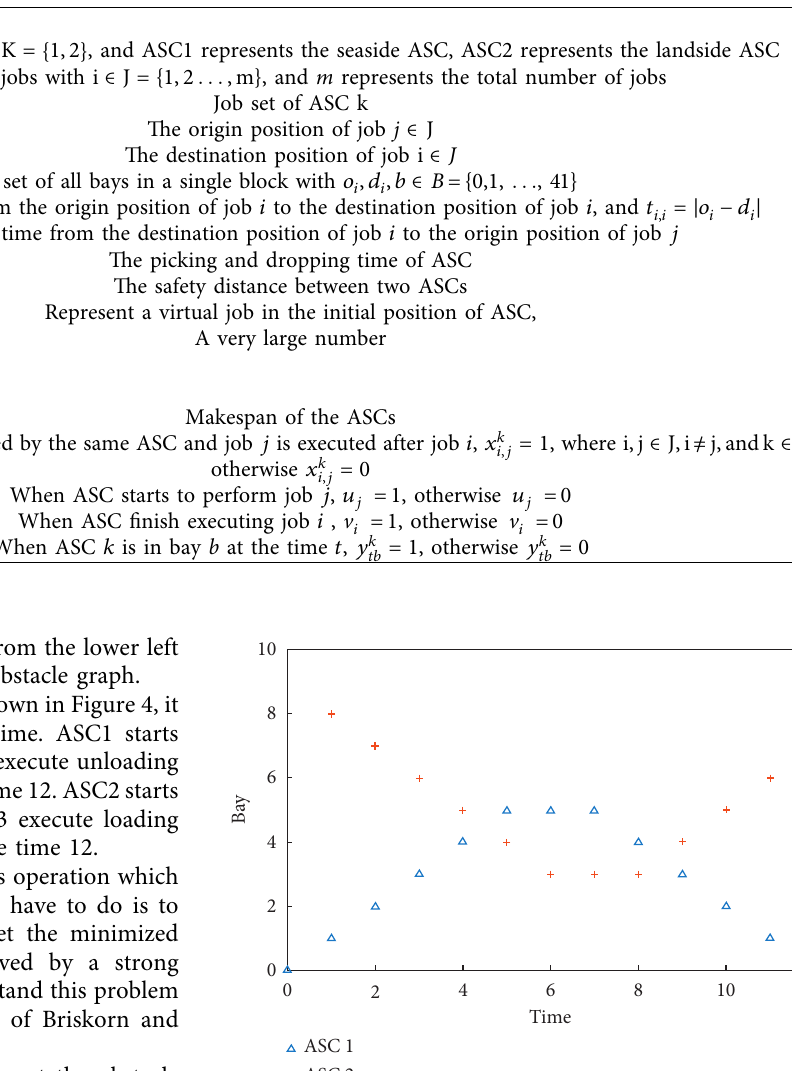
Table 1: Parameter notations.